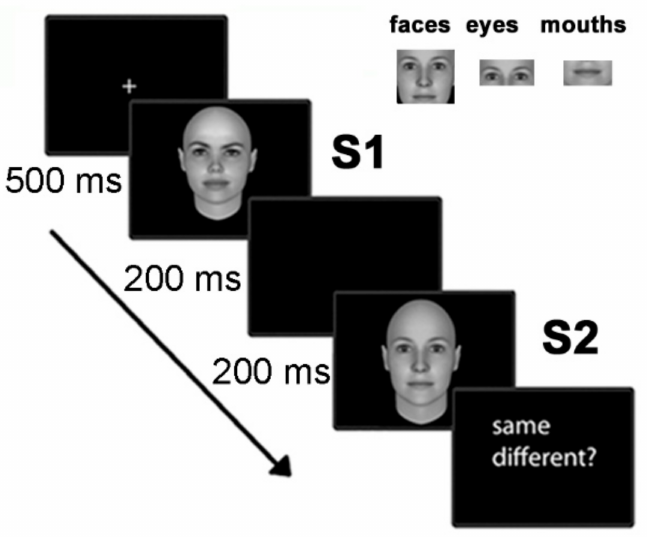
Figure 1. The procedure: A same/different matching task for repeated stimuli S1 and S2; the stimuli consisted of whole faces, mouths or